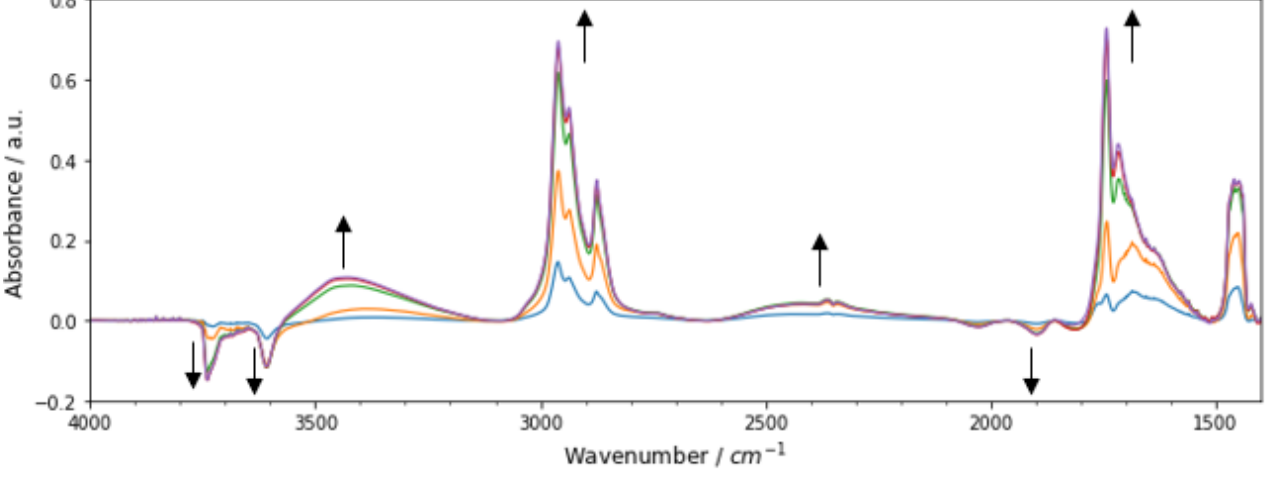
Figure 6. FT-IR difference spectra of methyl n -hexanoate adsorption on H-ZSM-5 SAR80 zeolite at 110 °C collected once per minute. The arrows indicate change in the spectrum over time.